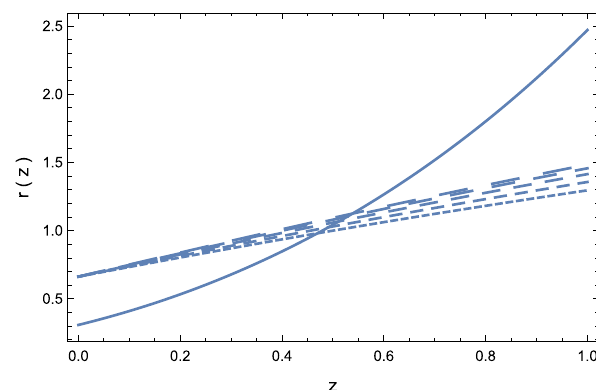
Fig. 1 Variation of the Hubble function as a function of the redshift z in the f ( Q , T ) gravity theory for f ( Q , T ) = − α Q − β T 2 and for a dust Universe, for different values of the parameter λ : λ = 1 . 52 (dotted curve), λ = 1 . 64 (short dashed curve), λ = 1 . 75 (dashed curve), λ = 1 . 83 (long dashed curve), and λ = 1 . 88 (ultra long dashed curve),respectively.ThevariationoftheHubblefunctioninthestandard (cid:4) CDM model is also represented as the solid curve